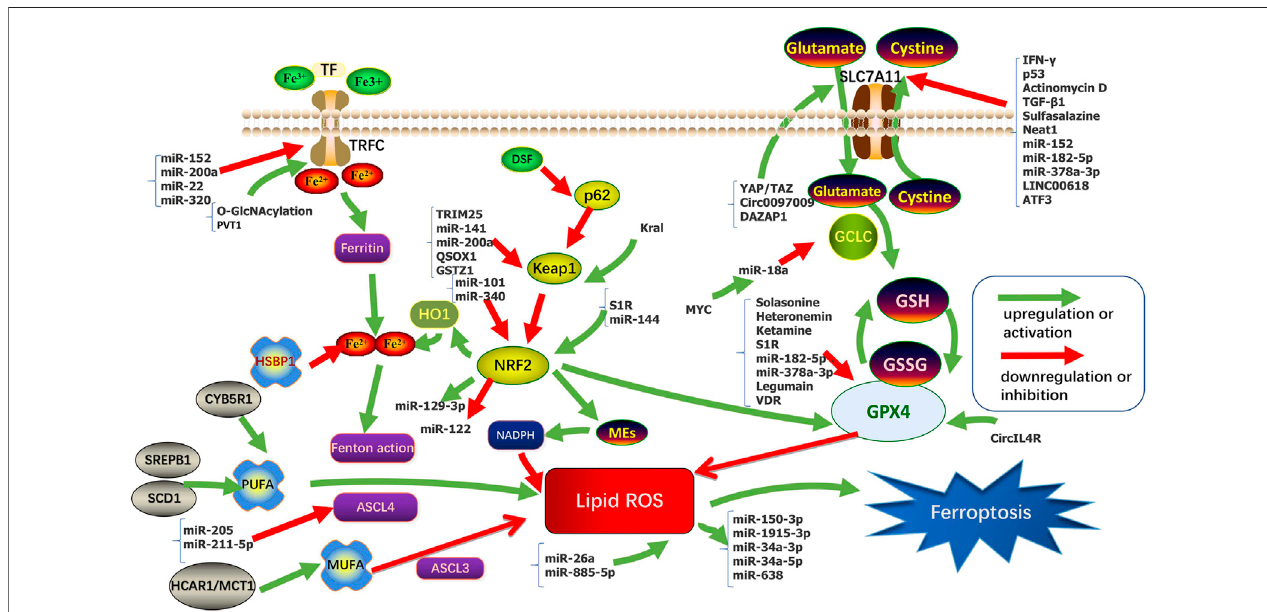
FIGURE 1 | Regulation pathways and key molecular mechanisms of ferroptosis in